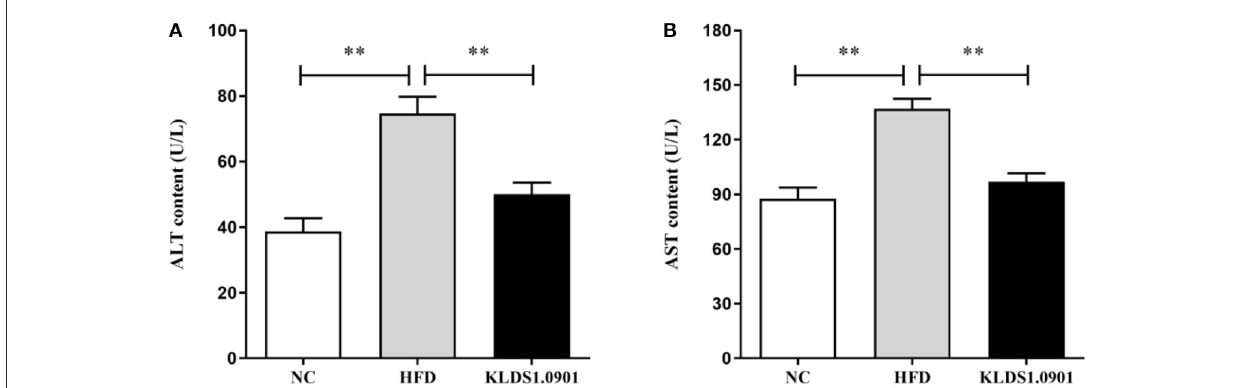
FIGURE3 Effects of L. acidophilus KLDS1.0901 administration on liver function. NC, normal control group; HFD, high-fat diet group; and KLDS1.0901, L. acidophilus KLDS1.0901 group. (A) Serum alanine aminotransferase (ALT) level; and (B) serum aspartate aminotransferase (AST) level. Values